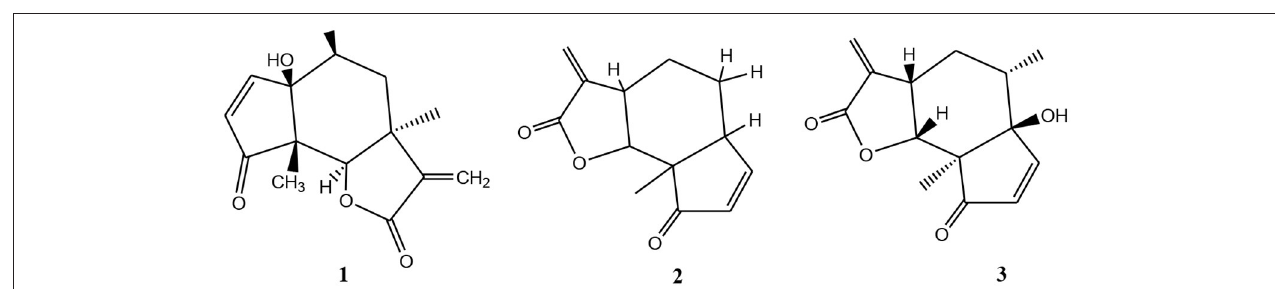
FIGURE 2 | The chemical structures of Parthenin (1) , Hymenin (2) , and Ambrosin (3)